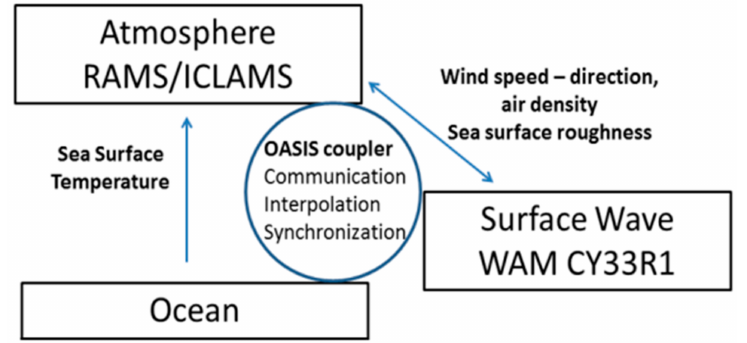
Figure 1. Model communication scheme.